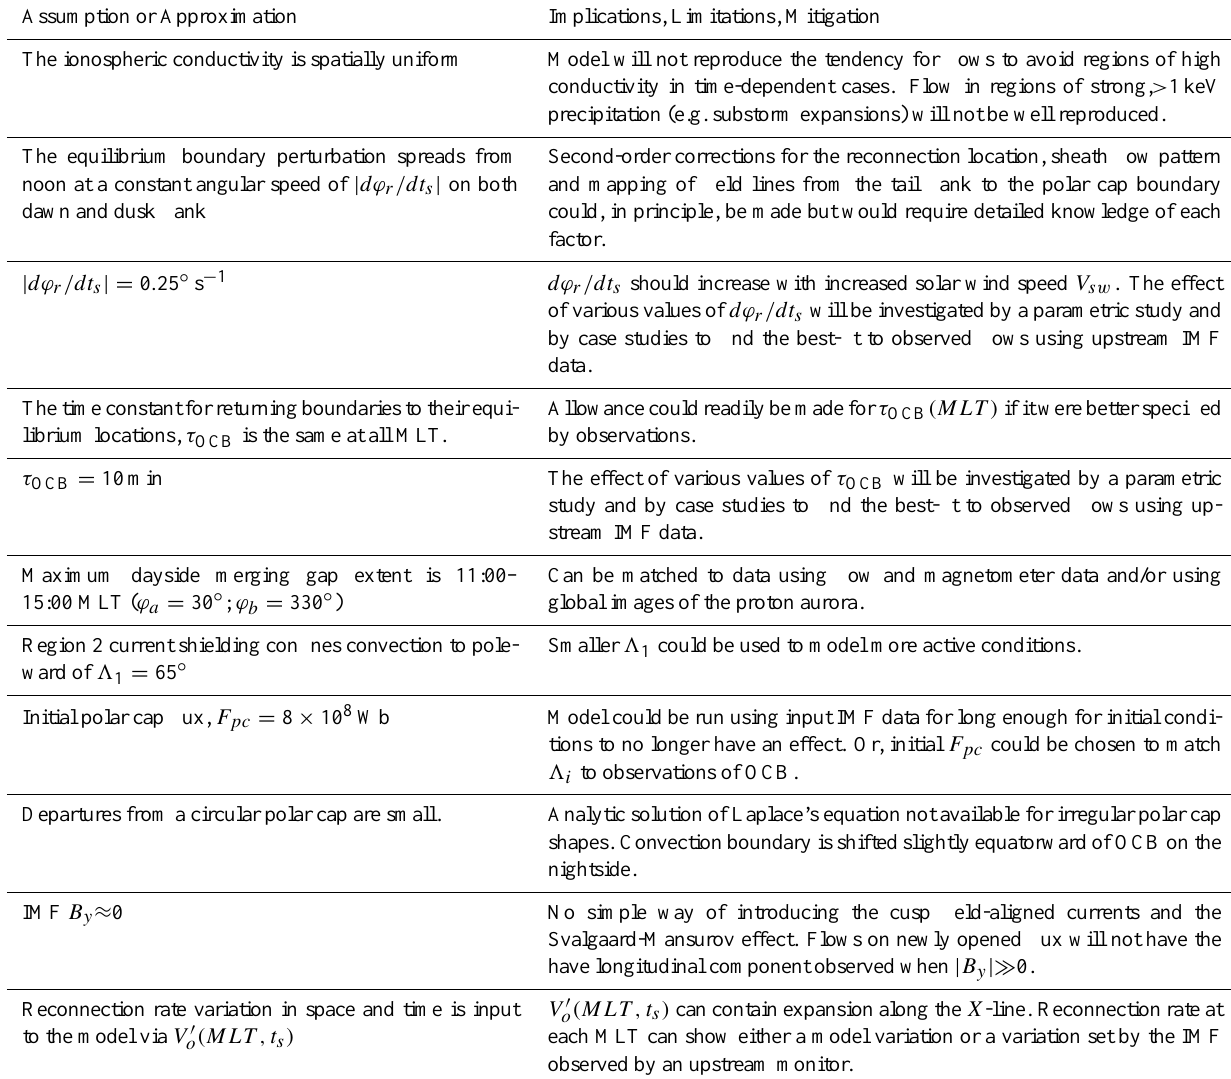
Table 1. Summary of assumptions and